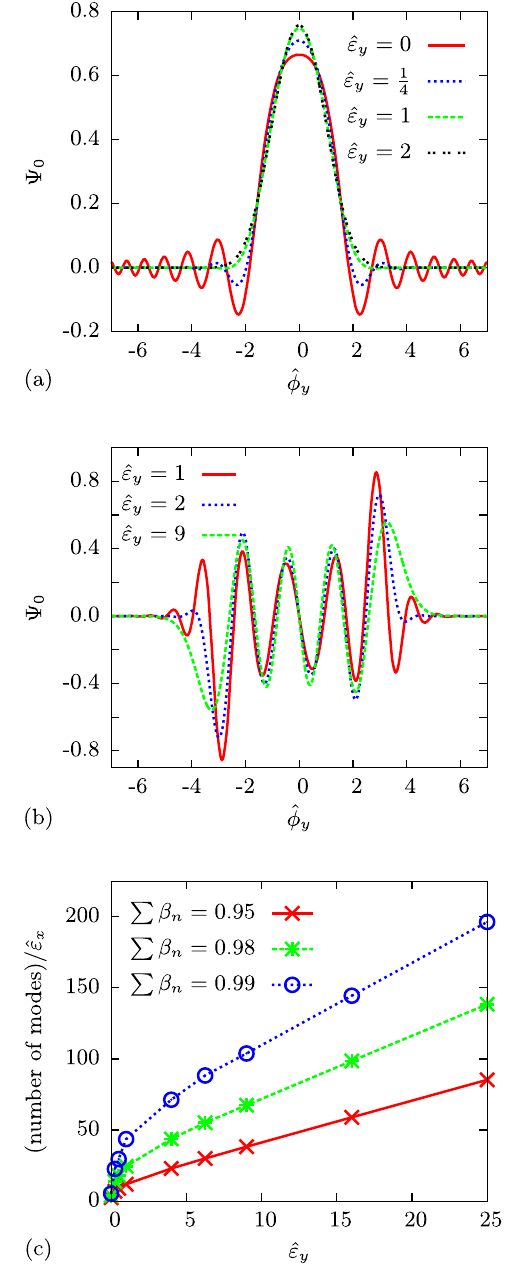
FIG. 5. Coherent mode expansion obtained by solving (42) and (43). (a) plots the lowest order mode Ψ 0 for four → 0 the mode different values of the emittance. When ε y is quite different than a Gaussian, but is nearly indistin- ≳ 4 . (b) plots guishable from the Gaussian prediction when ˆ ε y the eighth-order mode Ψ 7 for three different y emittances. The Gaussian-Schell model would lie almost exactly on the line 9 . Panel (c) shows how the required number of given by ˆ ε y ¼ coherent modes varies with the emittance ˆ ε for three different y levels of total flux contained: the solid red, dashed green, and dotted blue lines have the minimum number of modes to contain 95%, 98%, and 99% of the flux,